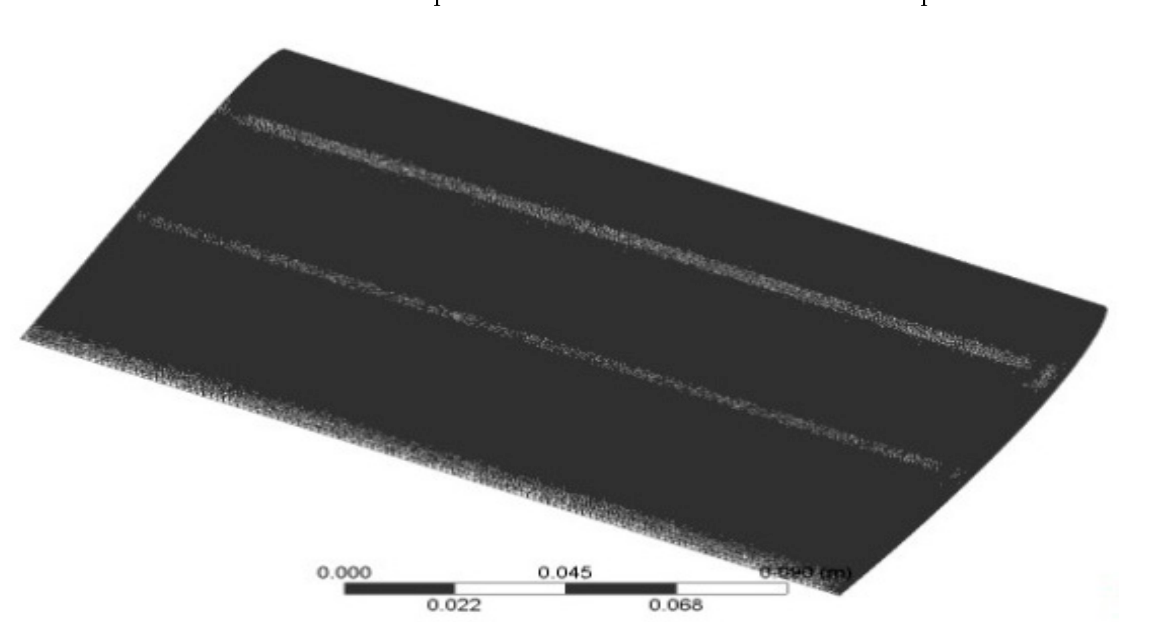
Figure 8. Discretized structure of a small UAV’s wing for structural and vibrational investigations.